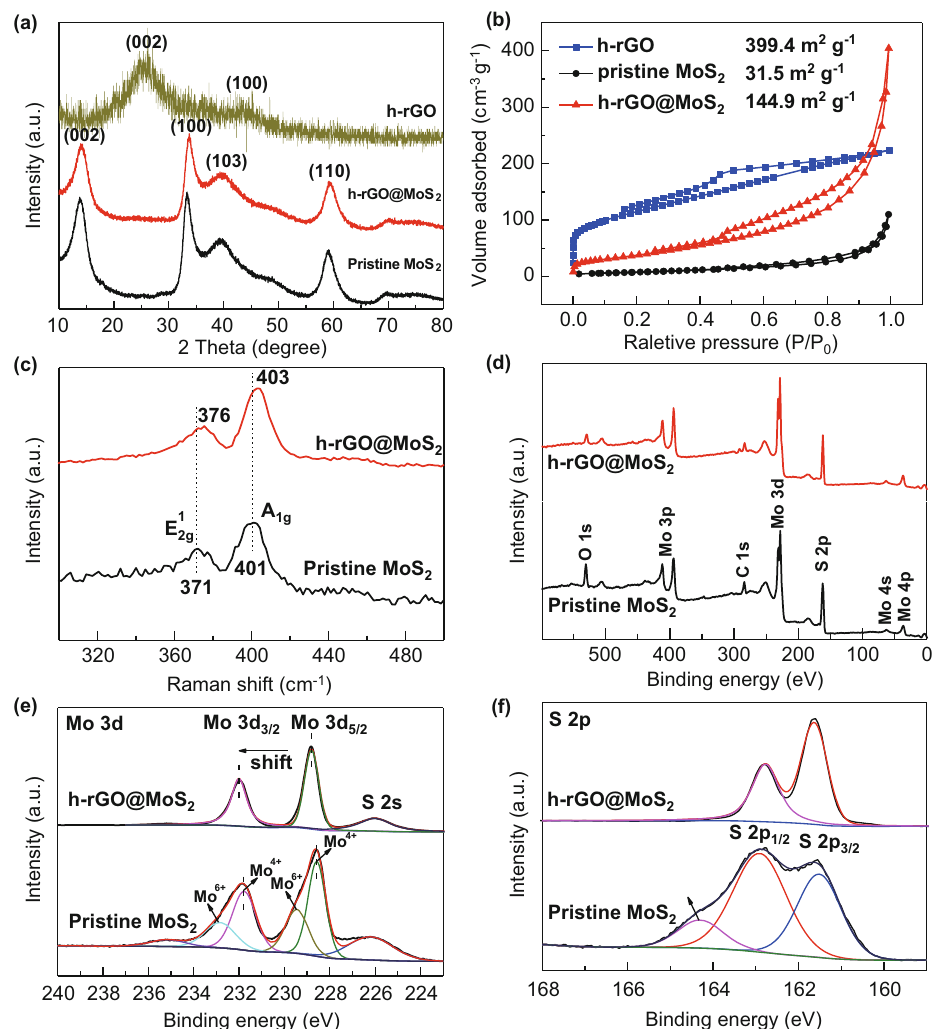
Fig. 2 a XRD spectra of h-rGO, pristine MoS 2 , and h-rGO@MoS 2 . b N 2 adsorption–desorption curves of h-rGO, pristine MoS 2 , and h-rGO@MoS 2 . The corresponding specific surface areas are given in the top left corner. c Raman spectra of pristine MoS 2 and h-rGO@MoS 2 measured with 532 nm excitation. d Survey spectra of pristine MoS 2 and h-rGO@MoS 2 . e , f The high-resolution Mo 3d and S 2p XPS spectra of pristine MoS 2 and h-rGO@MoS